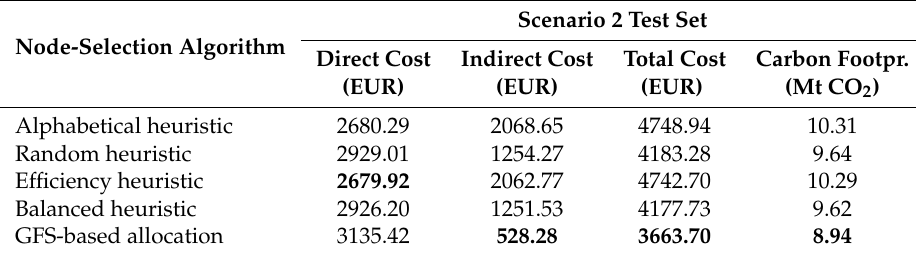
Table 4. Experiment results for the test set of Scenario 2.